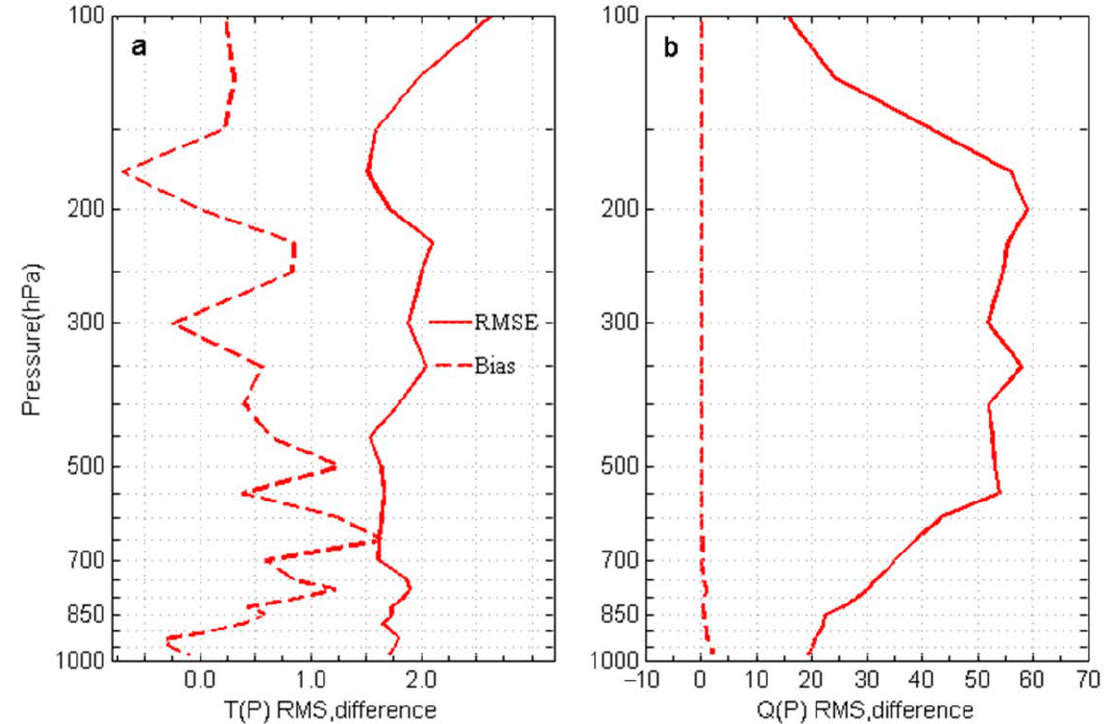
Figure 14. The RSE and bias of the temperature ( a ) and relative humidity ( b ) profiles between the retrieval results and RO